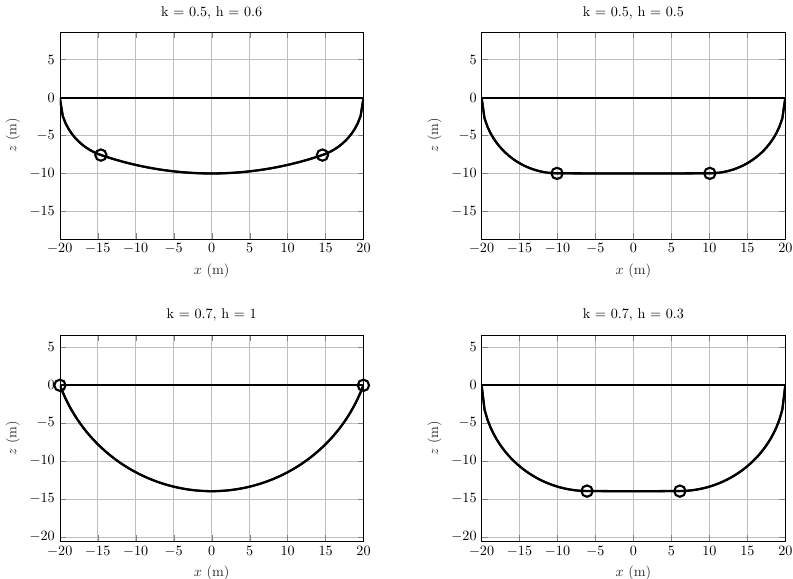
Figure 6. Examples of the effects of the h and k geometric design parameters.